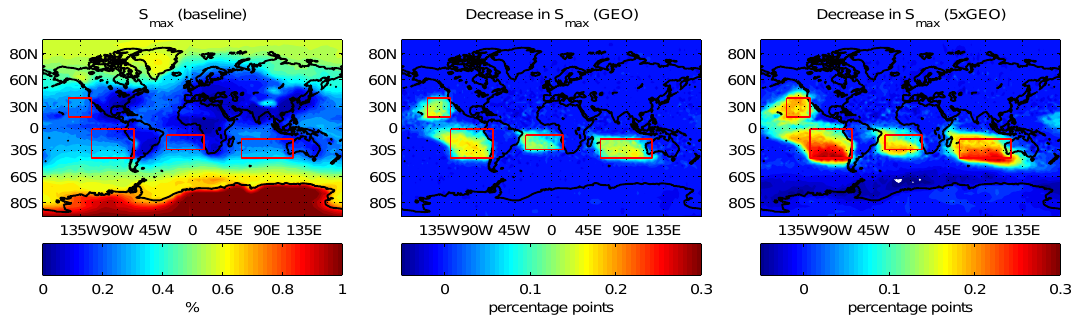
Fig. 5. Maximum supersaturation reached during cloud droplet activation at 1km altitude in the baseline run (left panel) and the decrease in supersaturation caused by sea spray injections (GEO middle panel; 5 × GEO right panel). All values are for updraft velocity 0.1m/s.